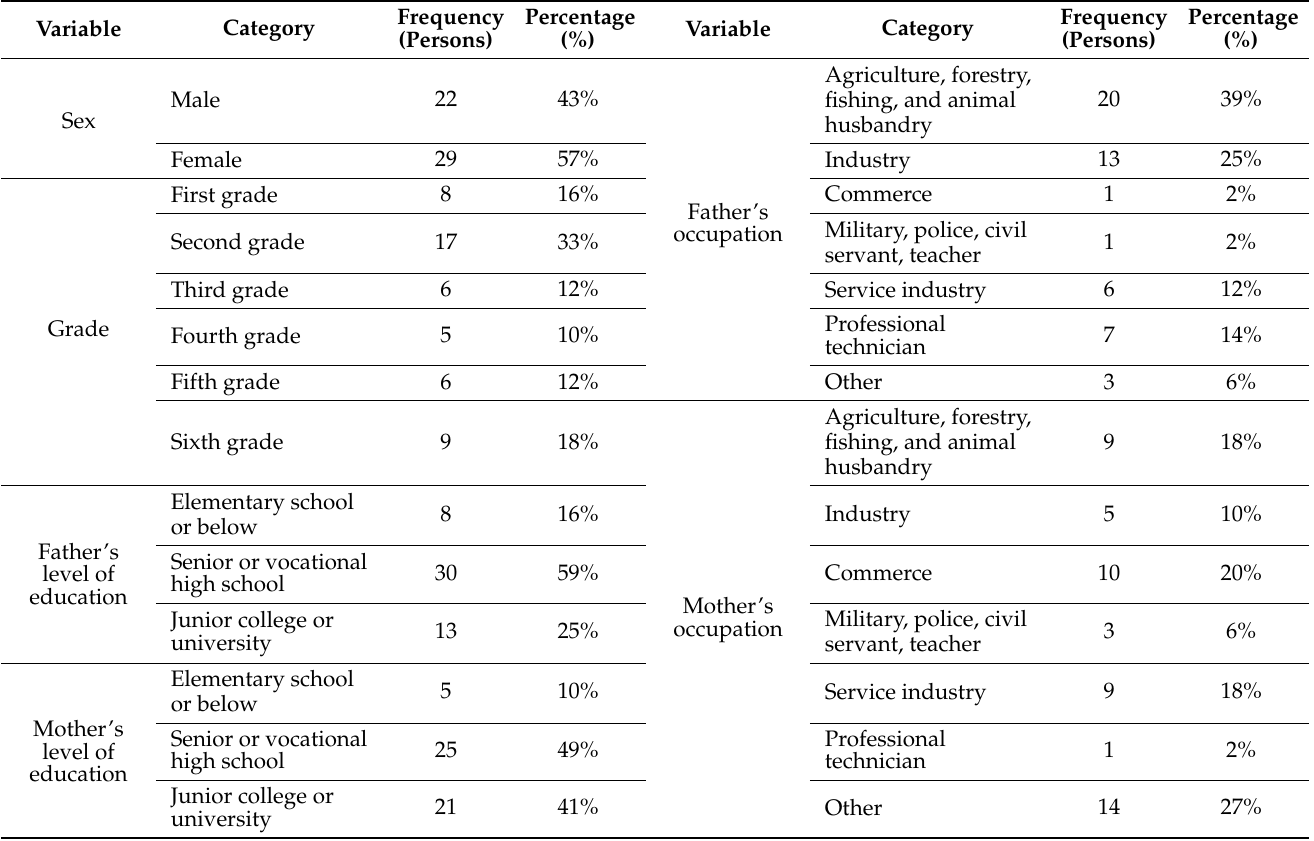
Table 2. Descriptive statistics of the sample (N =